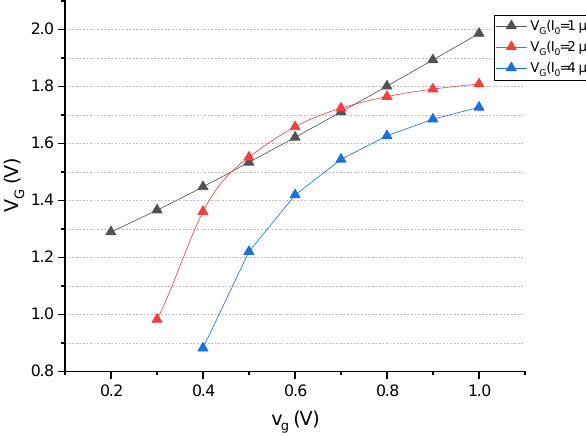
Figure 8. The calculation results of g 1 for constant I 0 .